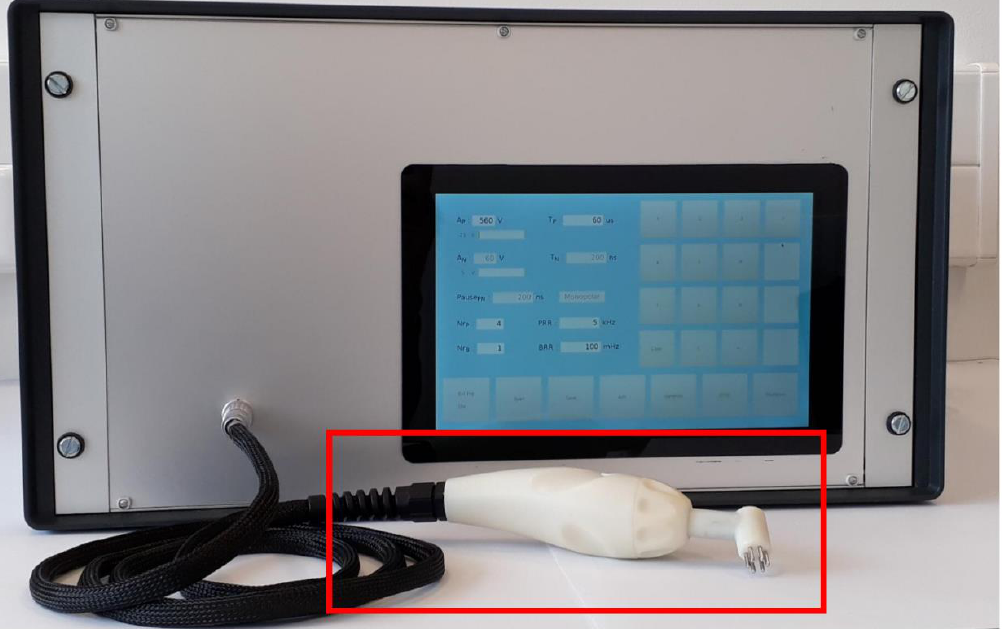
Figure 5. The completed device (pulse generator and applicator) for gene electrotransfer to skin cells. The applicator is shown inside the red frame.